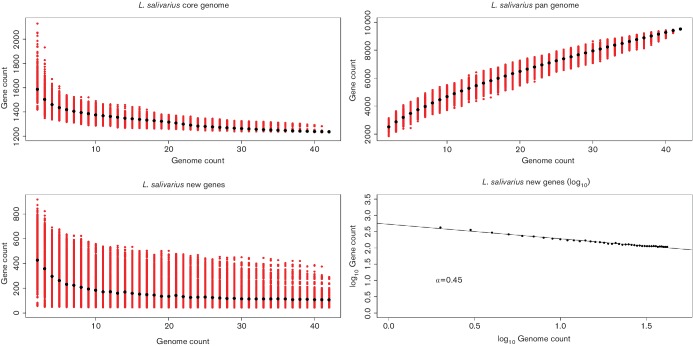
A dataset of 42 genomes is not sufficient to define the L. salivarius pan-genome. The four panels show, with the sequential addition of 42 L. salivarius genomes (x-axis), the decrease in core genes (a; top-left), the increase in total genes (b; top-right), the decrease in new genes (c; bottom-left) and the log of the decrease in new genes (d; bottom-right). Genes are counted as orthologous gene families (percentage identity >=40 and percentage alignment length >=50) except for genes unique to each genome. The order of addition of genomes has been permuted 1000 times. Red dots show the variation in values while black dots show the median value. An alpha value of 0.44 shows that the pan genome of L. salivarius is open (α<1).